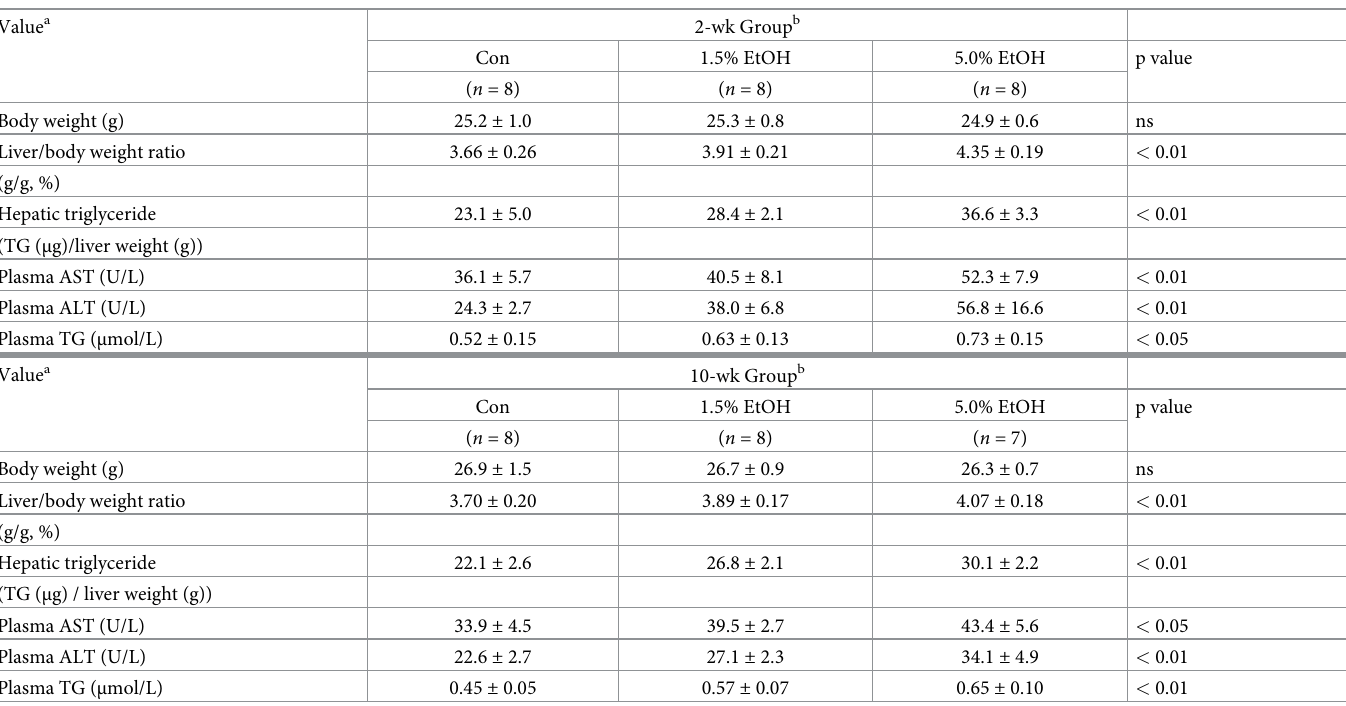
Table 1. Characterization of mice with chronic oral administration of